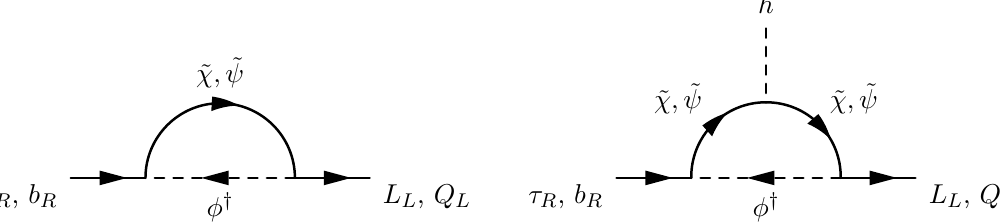
Figure 9. One-loop diagrams that generate effective τ -lepton and b -quark masses and effective Yukawa couplings after electroweak symmetry breaking in the Class 2